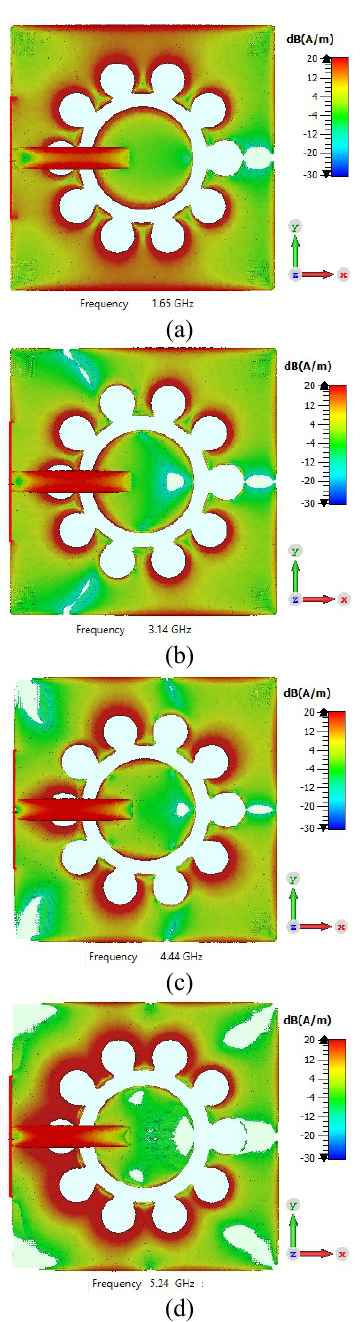
Figure 11: The current distributions on the surface of the proposed slot antenna at: (a) 1.65 GHz, (b) 3.14 GHz, (c) 4.44 GHz and (d) 5.24